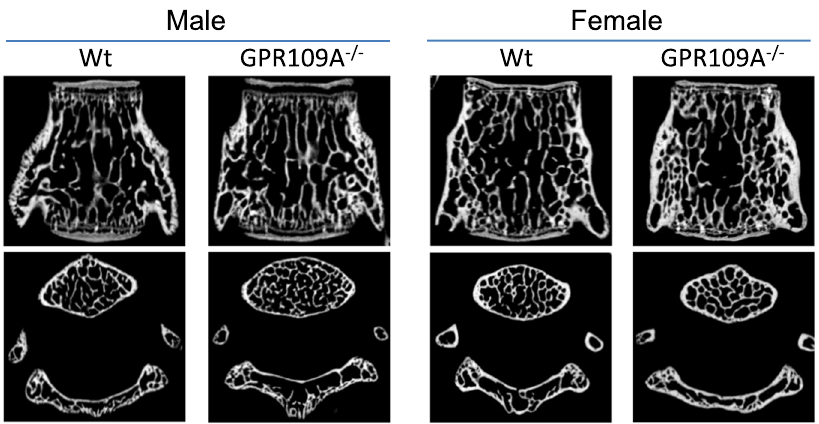
Fig. 2 Micro-CT on L5 vertebrae from male and female GPR109A − / − and wild type mice. Representative micro-CT images (sagittal view above, axial view below) of the L5 vertebrae from one sample from 4-weeks-old male and female of each group of GPR109A − / − and wild type (Wt) mice, white color